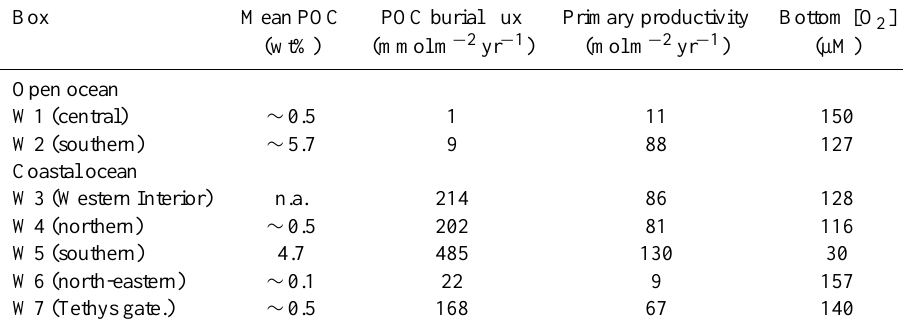
Table 1. Mean sediment POC contents for each box, where observations have been recorded, and corresponding POC burial fluxes, rates of primary productivity and oxygen concentrations in bottom waters for pre-OAE2 conditions. The mean POC contents have been calculated from the observations shown in Fig. 1 and Table S1. Box Mean POC POC burial flux Primary